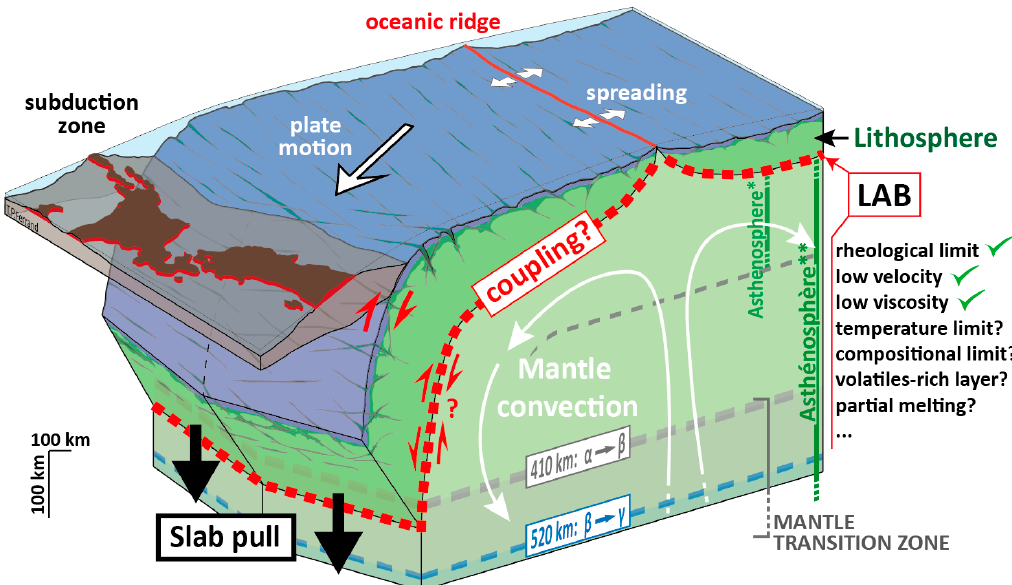
Figure 1. Sketch of the Pacific lithospheric plate focusing on the lithosphere–asthenosphere boundary (LAB). The LAB is a rheological limit that may have its own rheology (Sections 1 and 2). The LAB is usually simplified as a thermal limit at 1260 or 1300 °C and has a standard depth of 80–110 km for ages >40 Ma. While the overall shear direction is clear at the subduction interface, questions remain regarding the coupling or decoupling between the lithosphere and asthenosphere. For sake of clarity, only the continental crust of the overriding plate is represented. Figure adapted from [24] . For the discussion about the different definitions of the asthenosphere, see Section 5. Vertical exaggeration: × 3 . Tectonic plates are mostly made of peridotite, which constitutes ≈ 70% of the continental lithosphere (e.g., [25]) and >90% of the oceanic lithosphere (e.g., [26,27]).